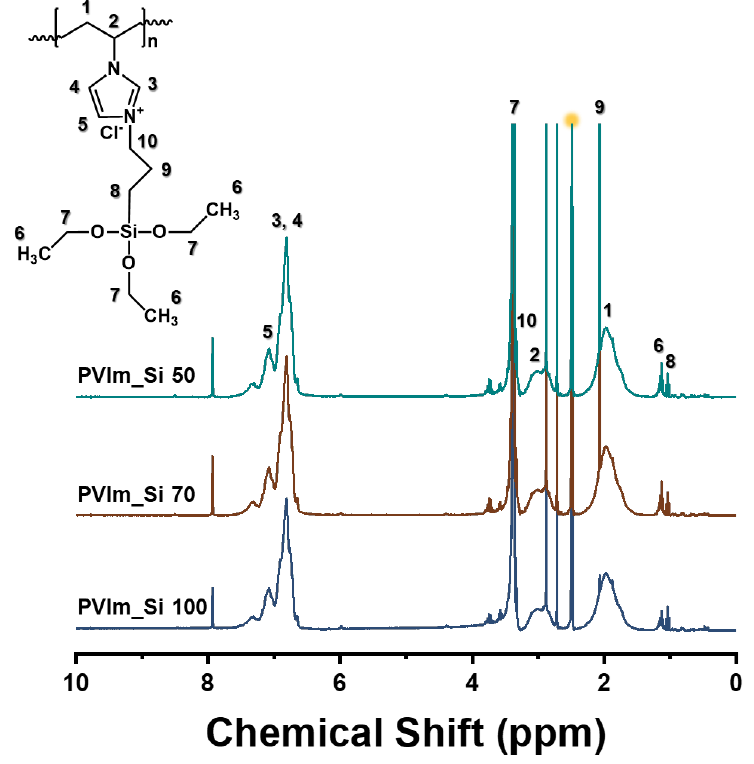
Figure 2. 1 H-NMR spectra of PVIm_Si.